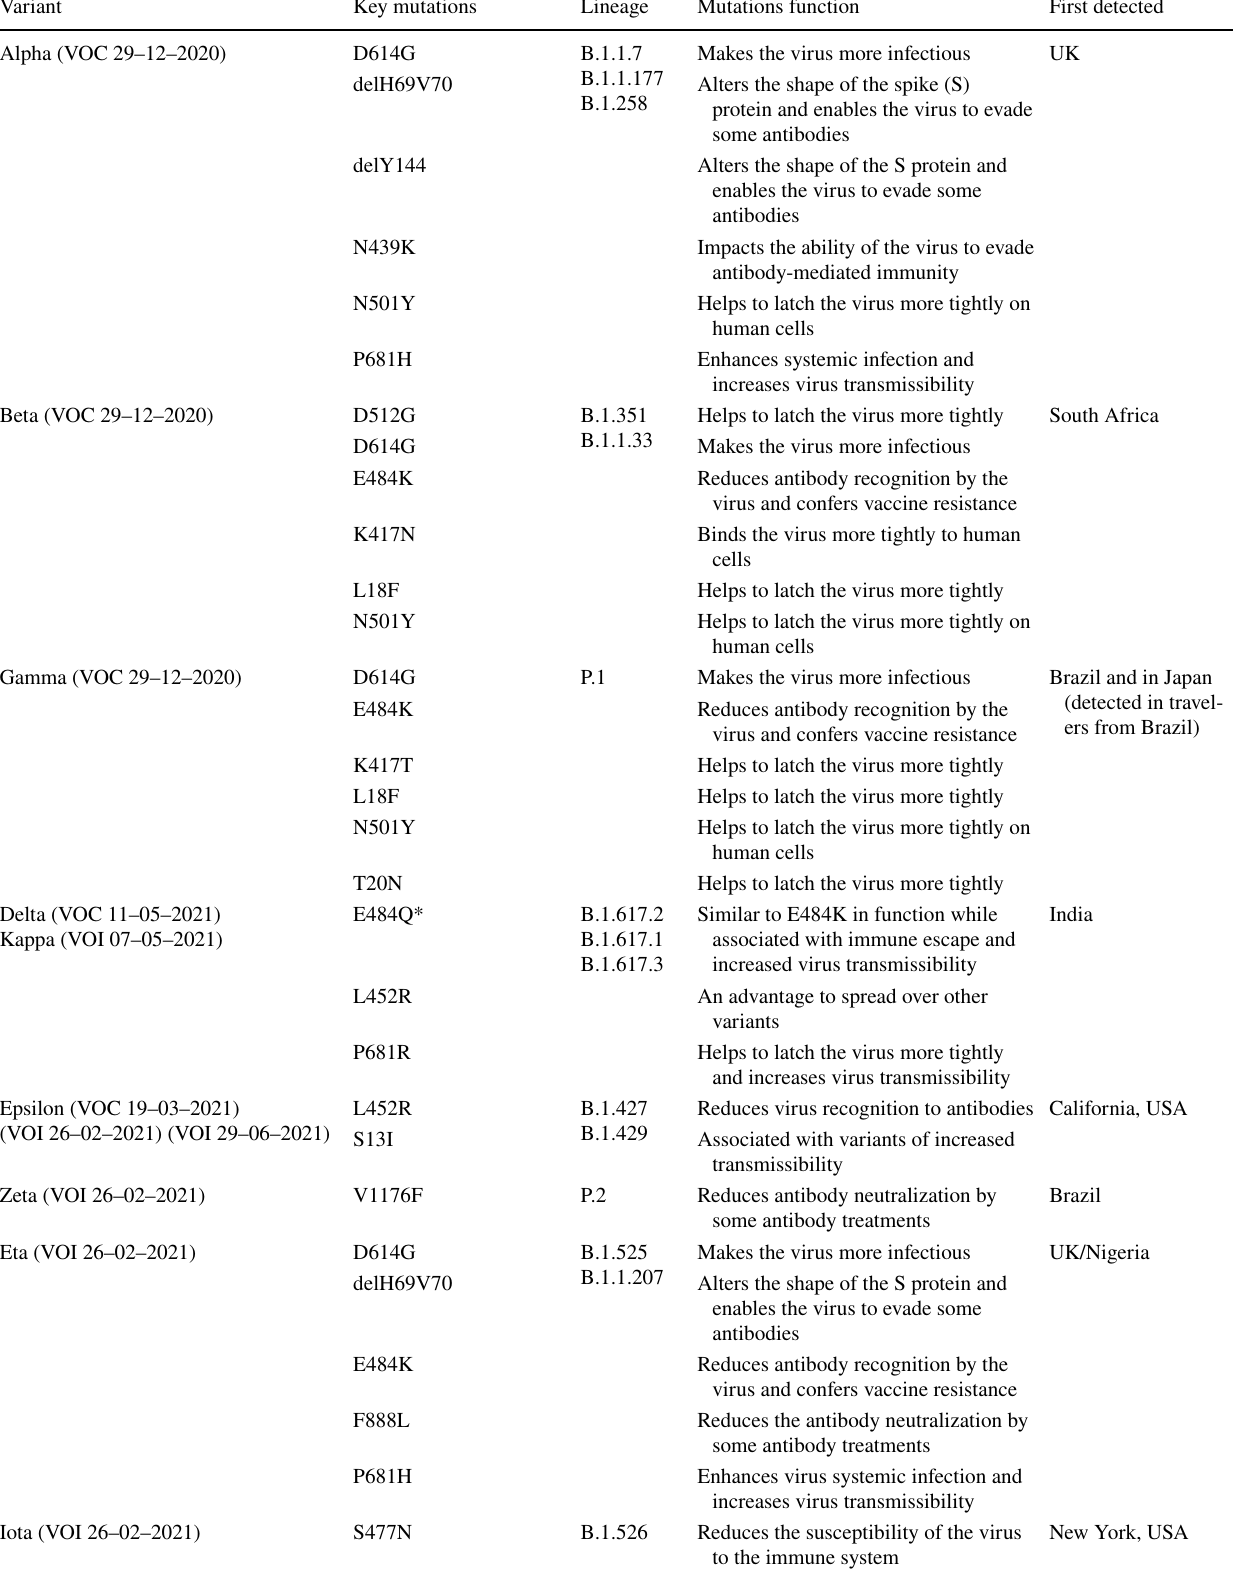
Table 1 SARS-CoV-2 variants with key mutations and their particular functions [3]